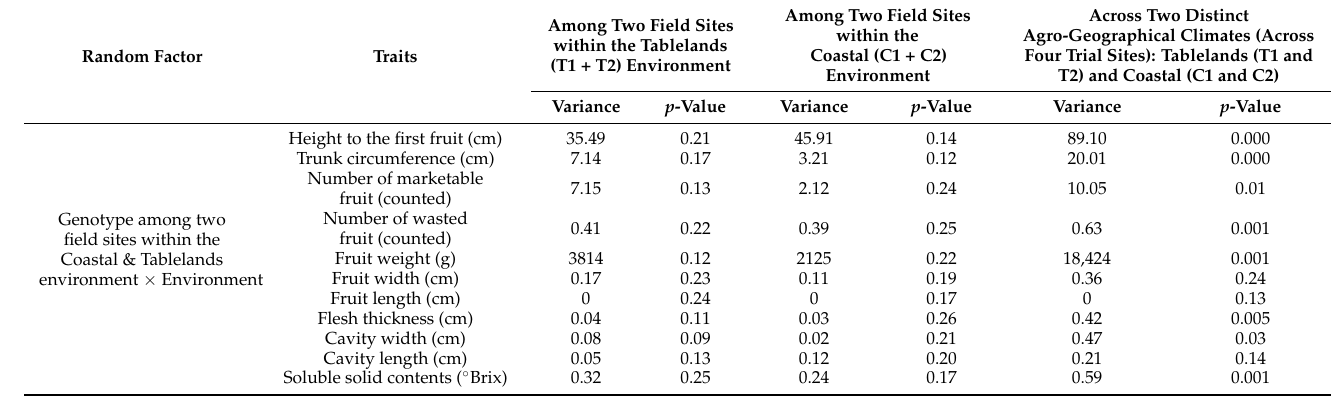
Table 1. Linear mixed models (LMM) of key agronomic and consumer-driven fruit quality traits fitted by residual maximum likelihood (REML; p < 0.05). The variance components of the interactions between genotypes (G) x environments (E) were calculated in two distinct agro-geographical climates [(Tableland: T1 and T2)] or [(Coastal: C1 and C2)] in Tropical North Queensland, Australia. Among Two Field Sites Across Two Distinct Among Two Field Sites within the Agro-Geographical Climates (Across within the Tablelands Coastal (C1 + C2) Four Trial Sites): Tablelands (T1 and Random Factor Traits (T1 + T2) Environment Environment T2) and Coastal (C1 and C2) Variance p -Value Variance p -Value Variance p